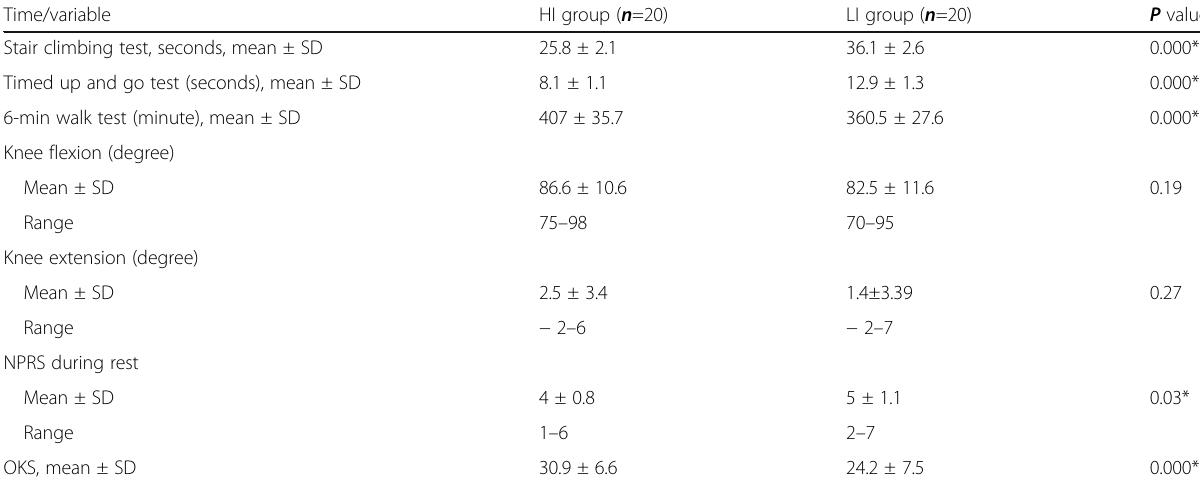
Table 2 Post-operative outcome measures of both groups at 1 month Time/variable